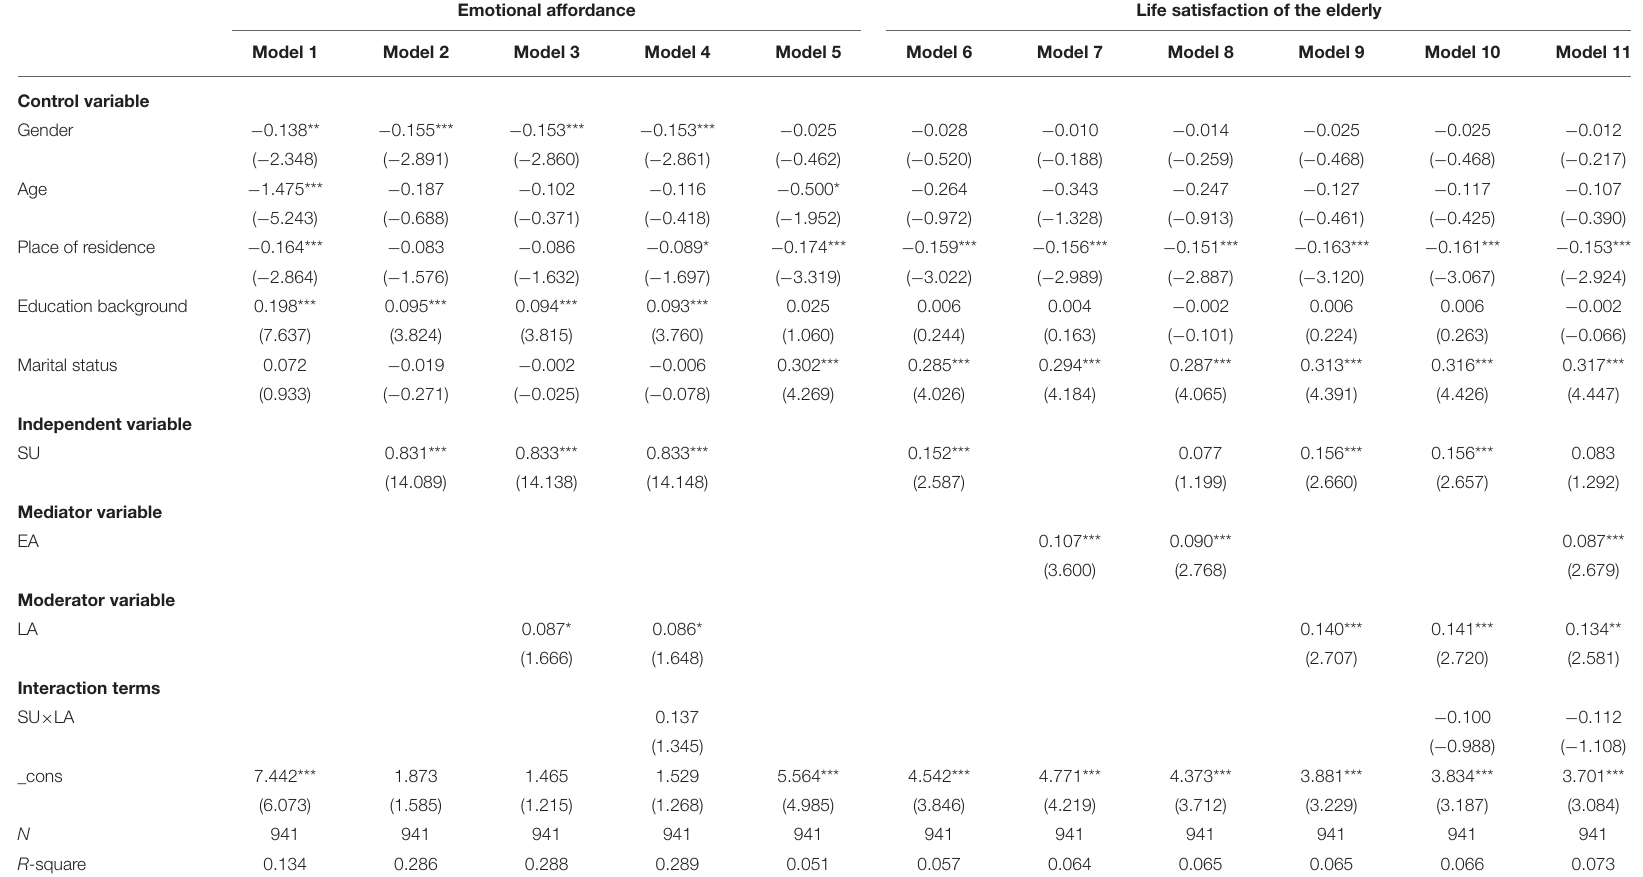
TABLE 4 | The hierarchical regression results including mediating effect of emotional